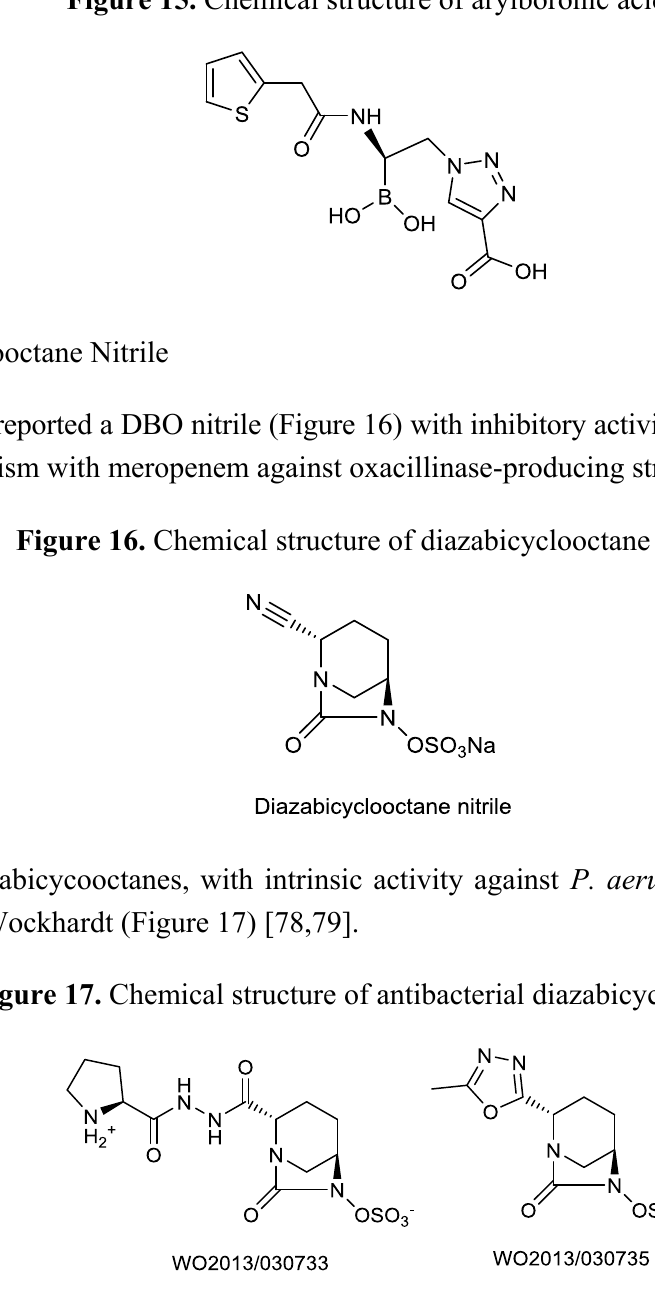
Figure 15. Chemical structure of arylboronic acids.